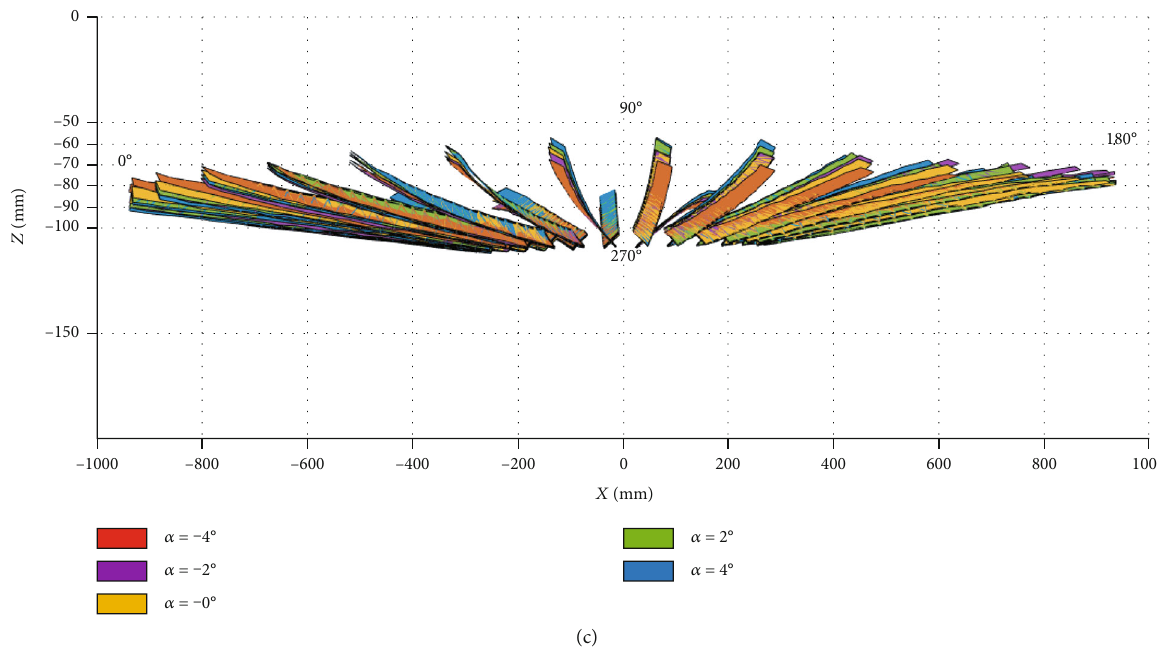
Figure 19: 3D reconstruction results of the measured rotor blade over its full rotating range at fi ve di ff erent rotor shaft angles in forward fl ight: (a) top view; (b) side view along the y -axis; (c) side view along the x